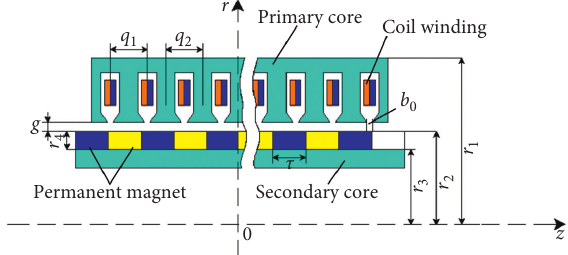
Figure 4: Structural dimension diagram of actuator. b